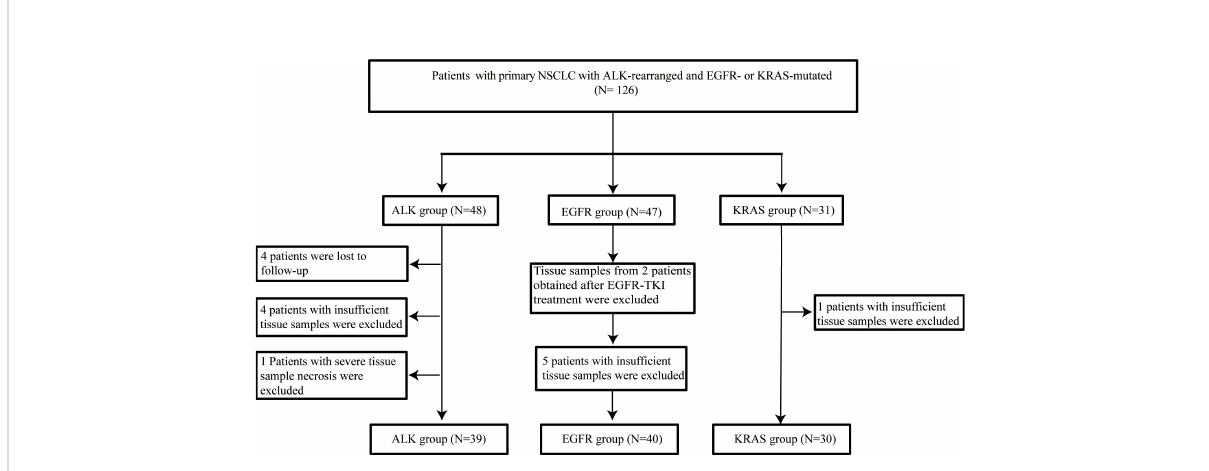
FIGURE 1 Flow chart for inclusion or exclusion of patients and